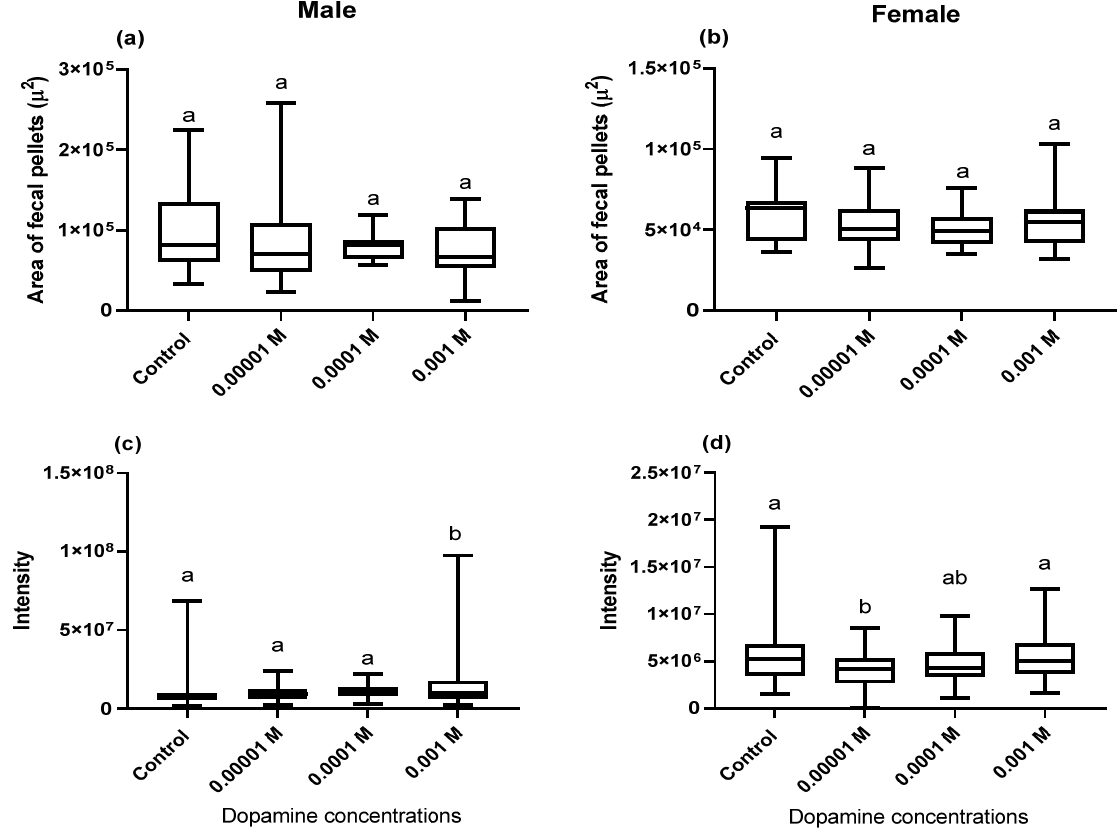
Figure 1. The gut content ( a , b ) and the fecal pellets count ( c , d ) of adult flies ( n = 5) fed on blue food media spiked with different concentrations of dopamine compared to control flies fed standard food media without dopamine. Symbols on the box plot represent the maximum and minimum values (whiskers: ┬ ┴ ) and mean values (-). Different lowercase letters indicate statistically significant dif- ferences between treatments (one-way ANOVA with Tukey’s post hoc test, p < 0.05). dia to quantify the effect of dopamine on the defecation rate of both male and female flies. Sex-specific discrepancy was observed where only male flies fed media spiked with the highest concentration of dopamine (1 M) had substantially more fecal pellets than the con- trol male flies fed standard food media without dopamine (F = 5.21 df = 4, p = 0.003; Figure 1c). In addition, linear regression revealed that, in only the males, the number of fecal pellets was significantly associated with the increase in dopamine concentration (R 2 = 0.38, p = 0.001; Figure S1c), while the females did not show these alterations. We also evaluated the relationship between the effect of dopamine on the gut con- tents and fecal pellet counts in male and female flies to find out whether the change in gut contents is due to a change in the defecation or food consumption rates. The change in the gut contents and fecal pellets showed a nonsignificant correlation (males: r = 0.49, p = 0.39; females: r = 0.88, p = 0.11; Figure S1e,f), indicating a potential role for dopamine in modu- lating the feeding behavior. There was no significant change in the perimeters of the fecal pellets of both males and females maintained in dopamine-supplemented food media in comparison to the control flies fed on regular food media without dopamine (males: F = 1.33, df = 3 p = 0.26; females: F = 1.56, df = 3, p = 0.66; Figure 2a,b). The integrated intensity of the blue dye in the fecal pellets of both male and female flies fed dopamine-supplemented food media also changed significantly compared to the control flies and was conc.-dependent (males: F = 15.56, df = 3, p = 0.001; females: F = 6.60, df = 3, p = 0.001, Figure 2c,d).